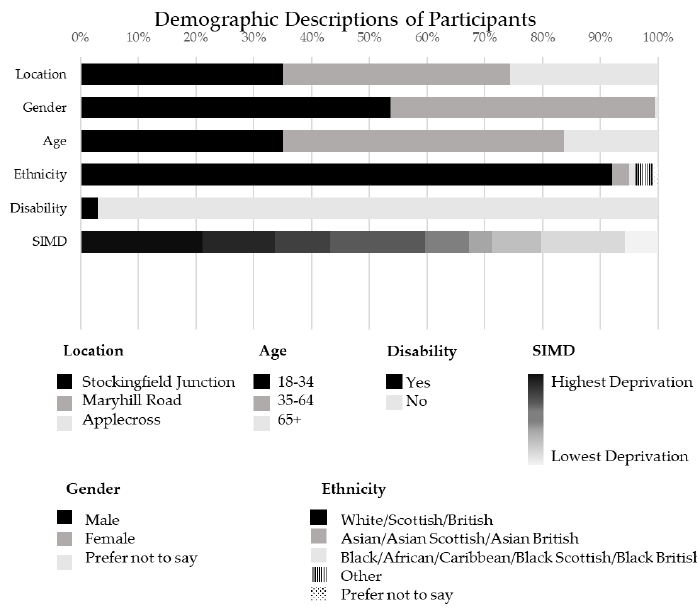
Figure 3. Demographic descriptors of participants [46].